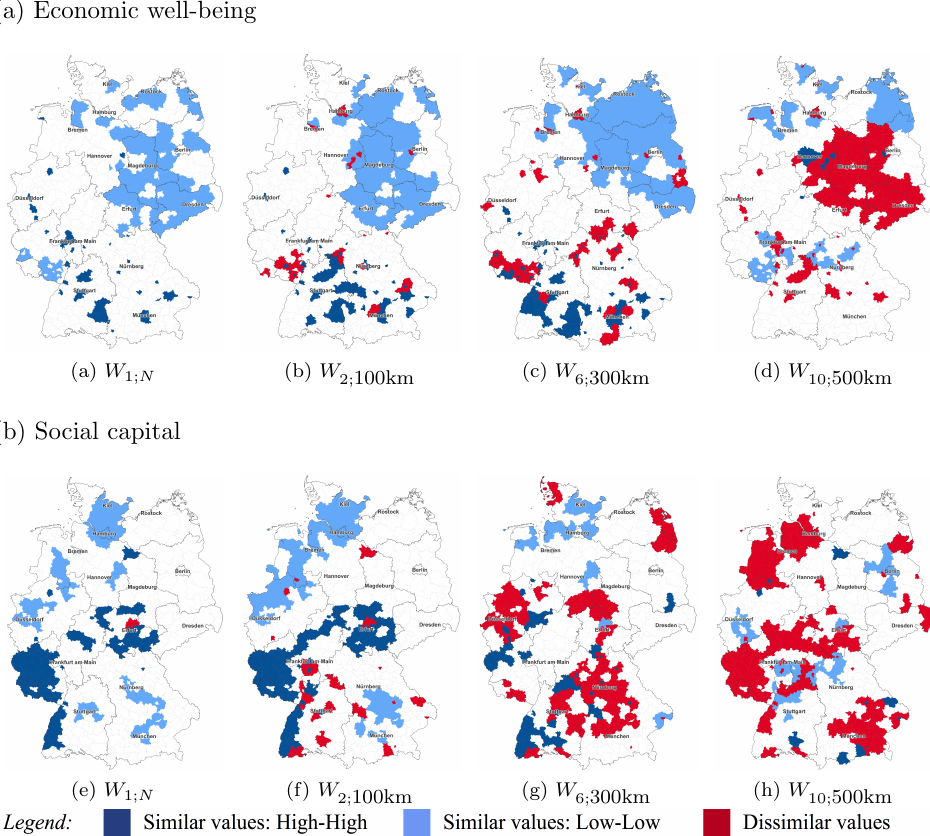
Figure 3: Significant Local Moran’s I (RegioGraph TM